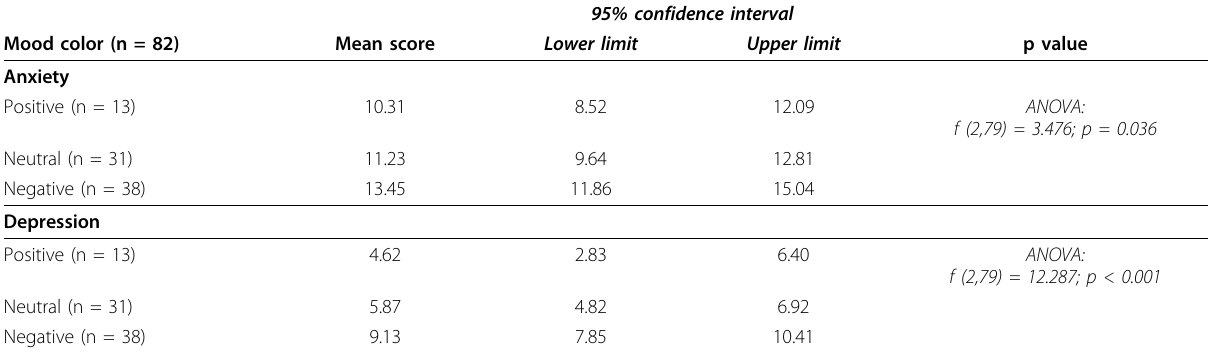
Table 3 Association between pre-HT anxiety and depression score and pre-HT mood color choice